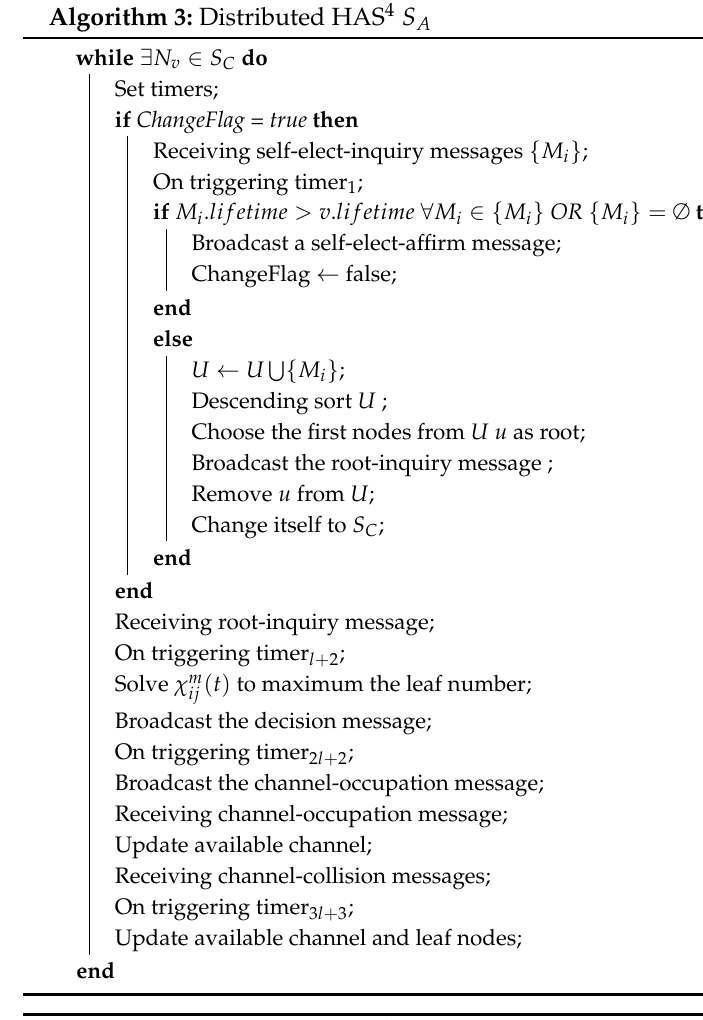
Algorithm 4: Distributed HAS 4 S U